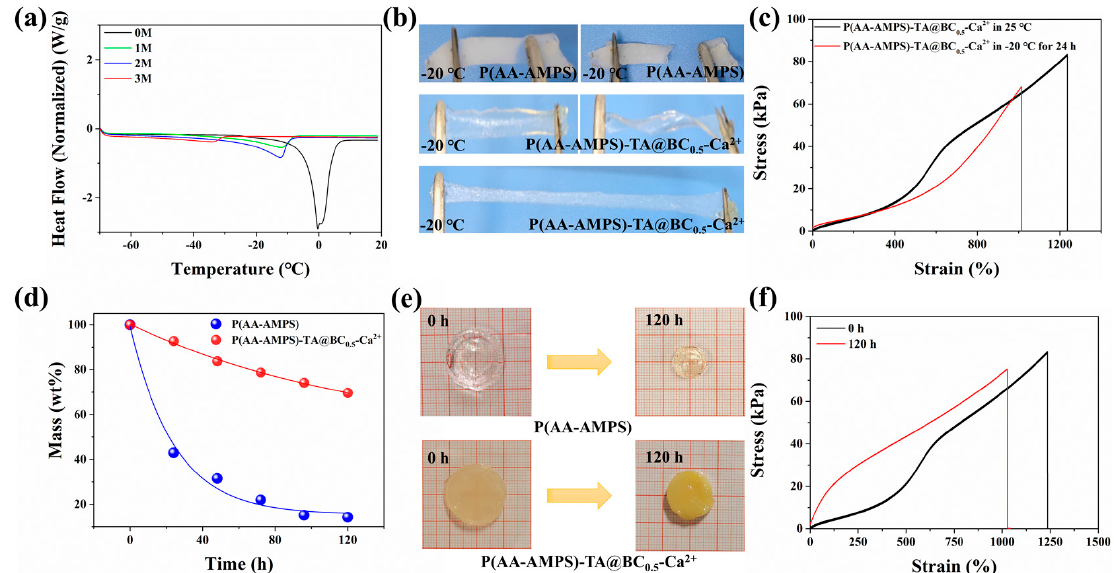
Figure 4. Anti ‐ freezing and moisturizing properties of the hydrogel. ( a ) DSC curves of P(AA ‐ AMPS) ‐ TA@BC 0.5 ‐ Ca 2+ hydrogels with different Ca 2+ concentrations during the heating process; ( b ) optical images of P(AA ‐ AMPS) and P(AA ‐ AMPS) ‐ TA@BC 0.5 ‐ Ca 2+ hydrogel at − 20 °C; ( c ) stress– strain curves of P(AA ‐ AMPS) ‐ TA@BC 0.5 ‐ Ca 2+ hydrogel before and after being stored at − 20 °C for 24 h; ( d ) mass curves of P(AA ‐ AMPS) and P(AA ‐ AMPS) ‐ TA@BC 0.5 ‐ Ca 2+ hydrogels at room temperature; ( e ) optical images of P(AA ‐ AMPS) and P(AA ‐ AMPS) ‐ TA@BC 0.5 ‐ Ca 2+ hydrogel in room temperature; ( f ) stress–strain curves before and after 120 h storage in room temperature.